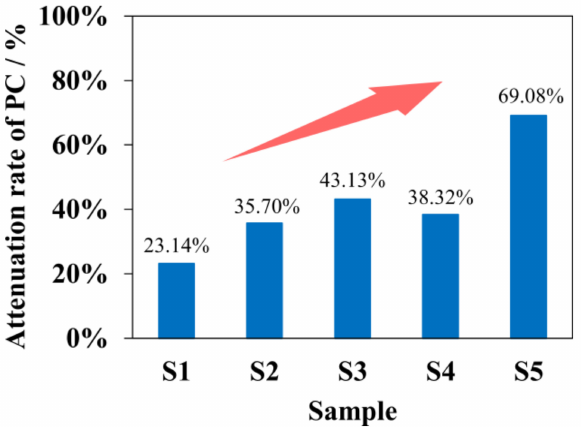
Figure 7. Attenuation rate of permeability coefficient during seepage (initial value–relatively stable